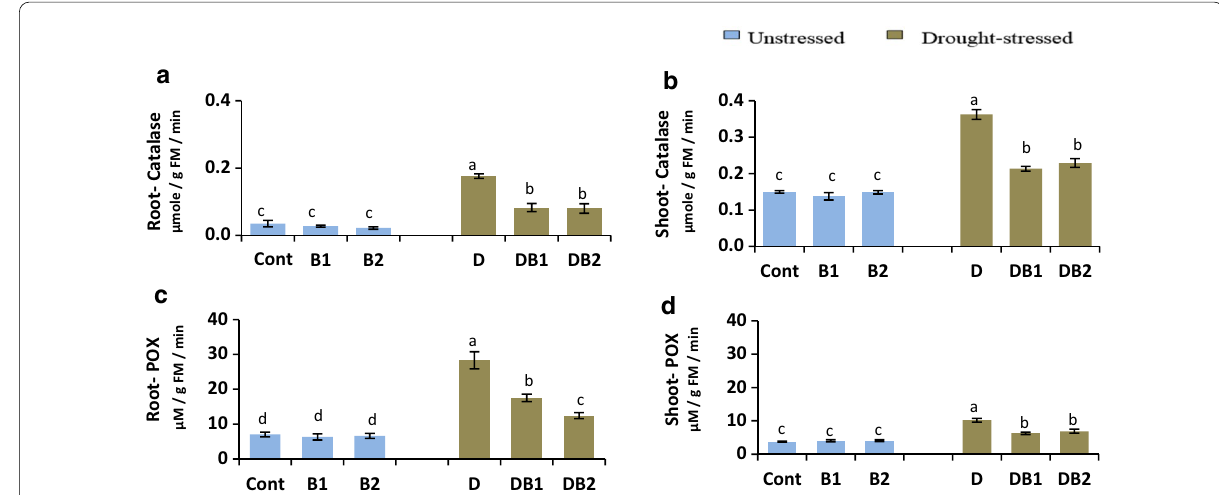
Fig. 7 Effect of bacterial inoculation with Azospirillum brasilense NO40 (B 1 ) and Stenotrophomonas maltophilia B11 (B 2 ) on a catalase activity of roots; b catalase activity of shoots; c peroxidase activity of roots; d peroxidase activity of shoots of the 15-day-old Triticum aestivum L. seedlings (cv. G9) grown in sandy soil, under unstressed and drought stressed conditions (7 days of water withholding). Error bars represent the standard deviation between 3 replica. Treatments with identical letters are not significant at P drought-stressed-uninoculated treatment; B 1 and B 2